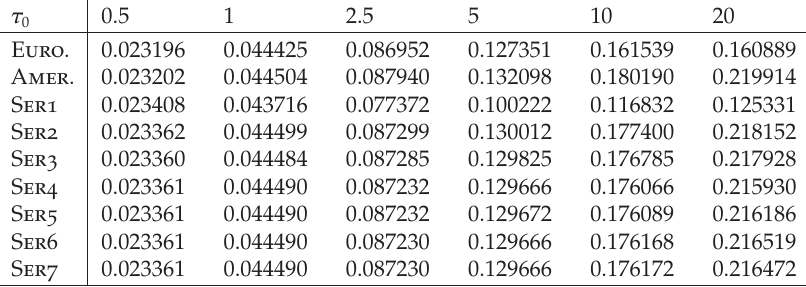
= 0 . 7, E = 0 . 4, r = 0 . 4, 0